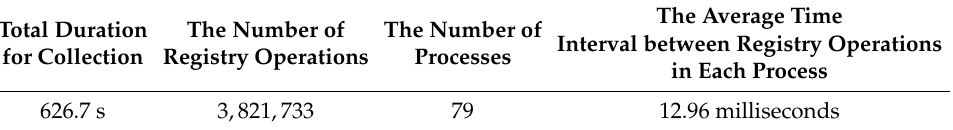
Table 8. The summarization of the collected registry